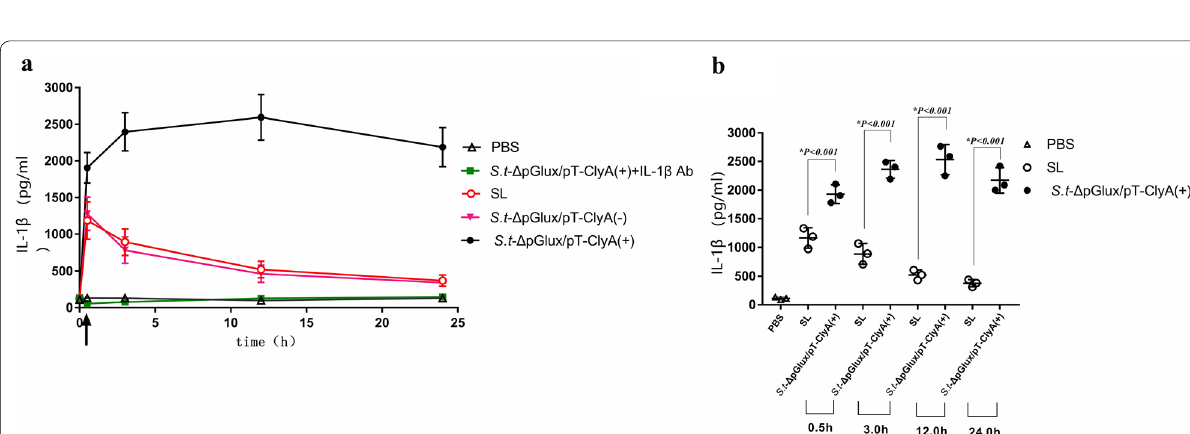
Fig. 4 Secreting-lux/pT-ClyA engineered bacteria repress tumor growth in vivo. Tumor volumes of the S. typhimurium carrying ClyA ( induction) group were smaller compared to other groups